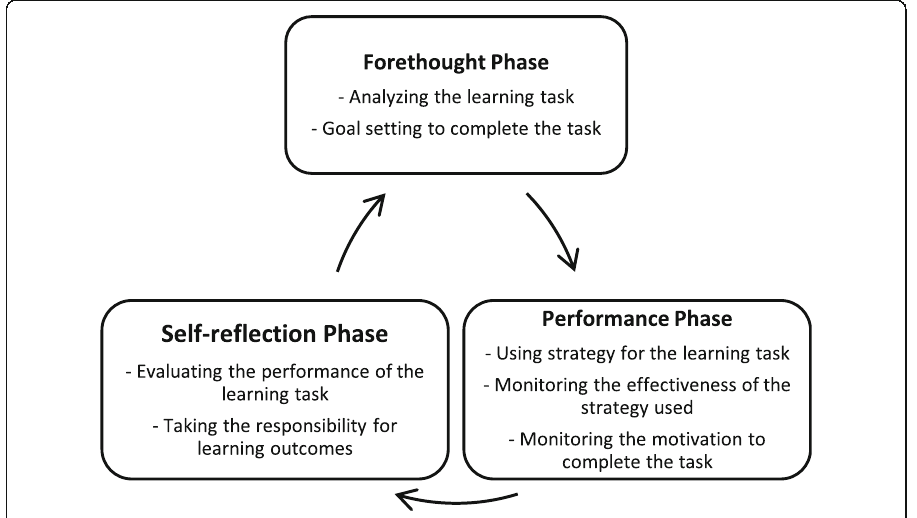
Fig. 1 Self-regulated learning phases (Adapted from Zumbrunn, Tadlock, & Roberts,